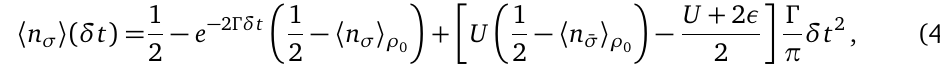
= | 0 〉〈 0 | . We note that the ( δ t 2 ) 0 O